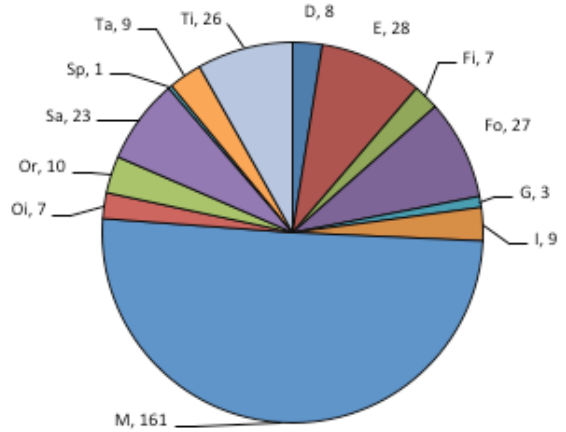
Figure 4. Local use (s) of plants for different